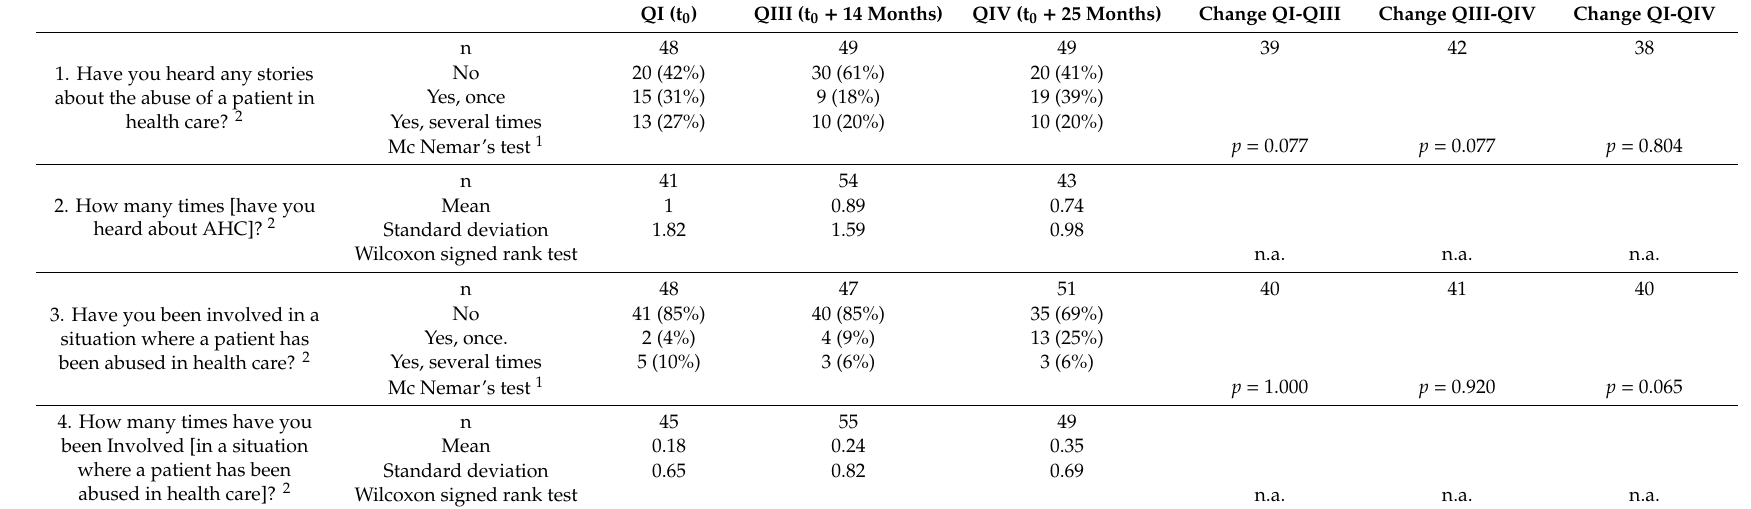
Table 3. Variables relevant for Hypothesis 1: FP participants’ awareness of